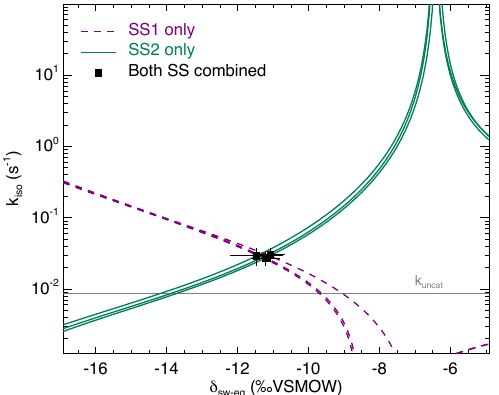
Figure 4. The CO 2 –H 2 O isotopic exchange rate ( k iso ) and iso- topic composition of soil water equilibrated with CO 2 ( δ sw ) re- trieved using the two-steady-state approach described in the main text (Eqs. 6a and 6b), for one single microcosm (LeBray1 with an α -CA addition of 24mgL − 1 ) . Relationships between k iso and δ sw for steady state 1 (dotted lines) and steady state 2 (solid lines) are also shown. In this example the microcosm was measured over three consecutive sequences, resulting in three curves for each steady state and three intersection points that coincide well with the two-steady-state solution for each sequence (black squares). The pH-dependent, un-catalysed CO 2 –H 2 O isotopic exchange rate (Uchikawa and Zeebe, 2012) is indicated by the grey horizontal